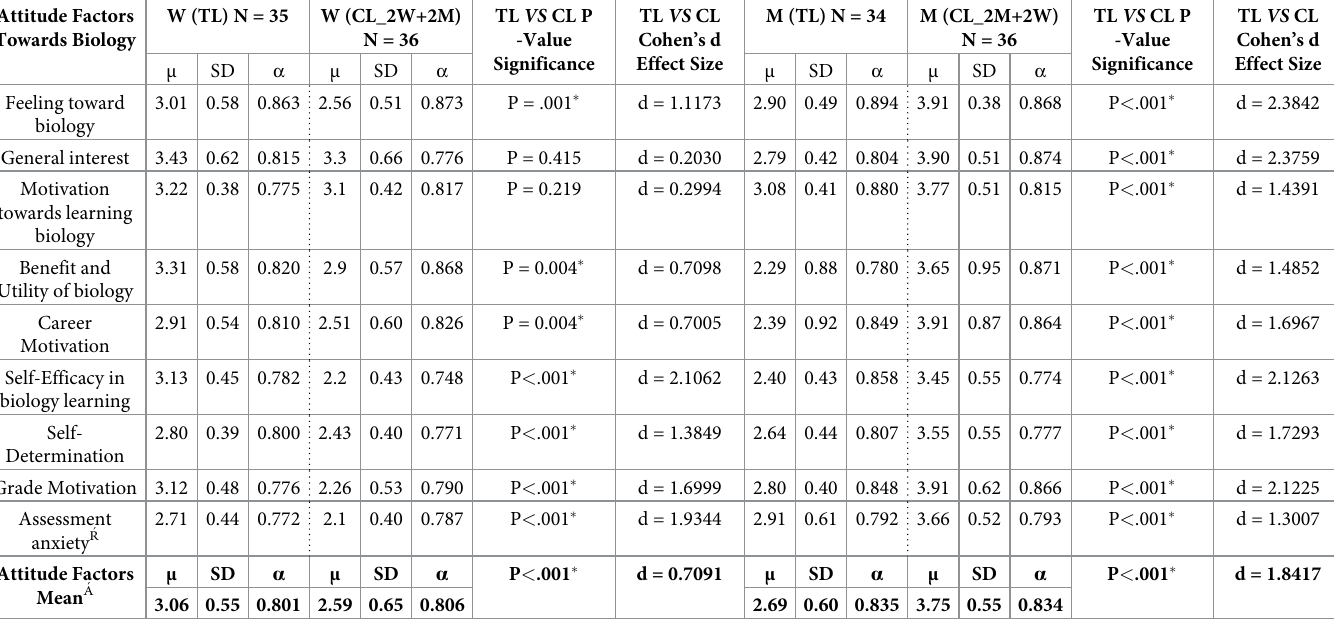
Table 3. Nonmajor mix-gender biology students, means and standard deviations attitude scores for each attitude factor. Attitude Factors Towards